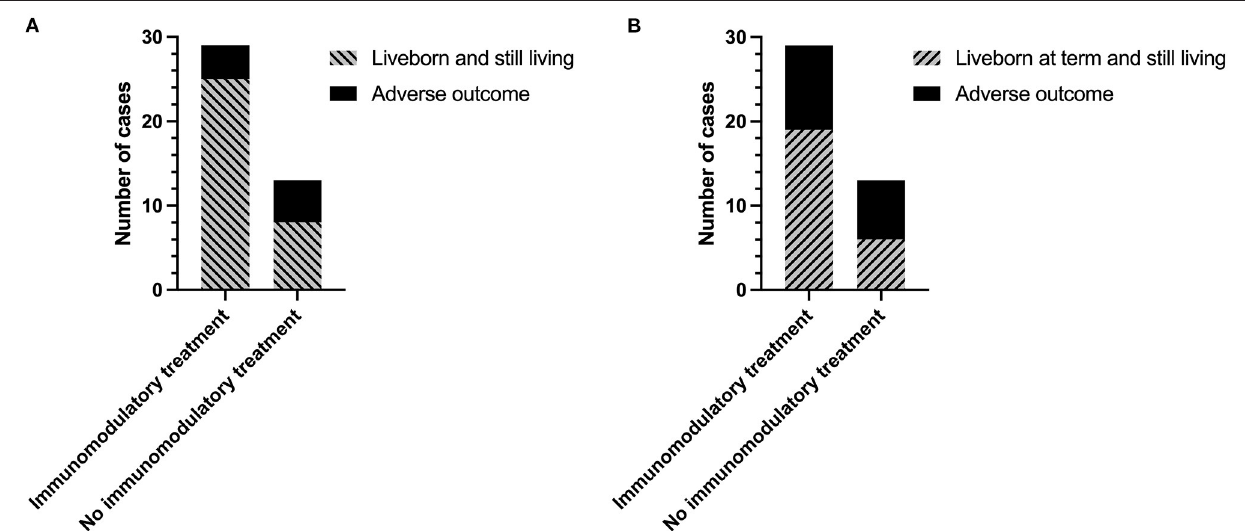
FIGURE 3 | Outcomes of subsequent pregnancies in women with a previous diagnosis of chronic histiocytic intervillositis (CHI) following treatment with or without immunomodulators. (A) Number of pregnancies resulting in a liveborn and still living infant (including those born < 37 weeks’ gestation) or adverse outcome (miscarriage, termination of pregnancy, stillbirth, or neonatal death). (B) Number of pregnancies resulting in a liveborn and still living infant at term ( > 37 weeks), or adverse outcome (miscarriage, termination of pregnancy, stillbirth, preterm birth, or neonatal death) Immunomodulatory treatment refers to a regimen including one or both of prednisolone and hydroxychloroquine in combination with either aspirin, heparin, or both. Pregnancies without immunomodulatory treatment were untreated or received aspirin or heparin or both.